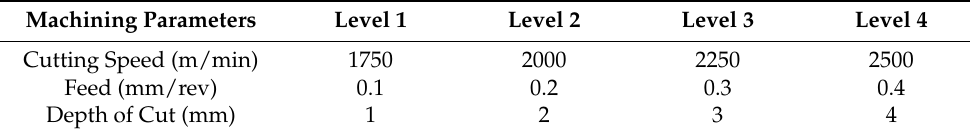
Table 3. L 16 experimental plan for high-speed machining (HSM).